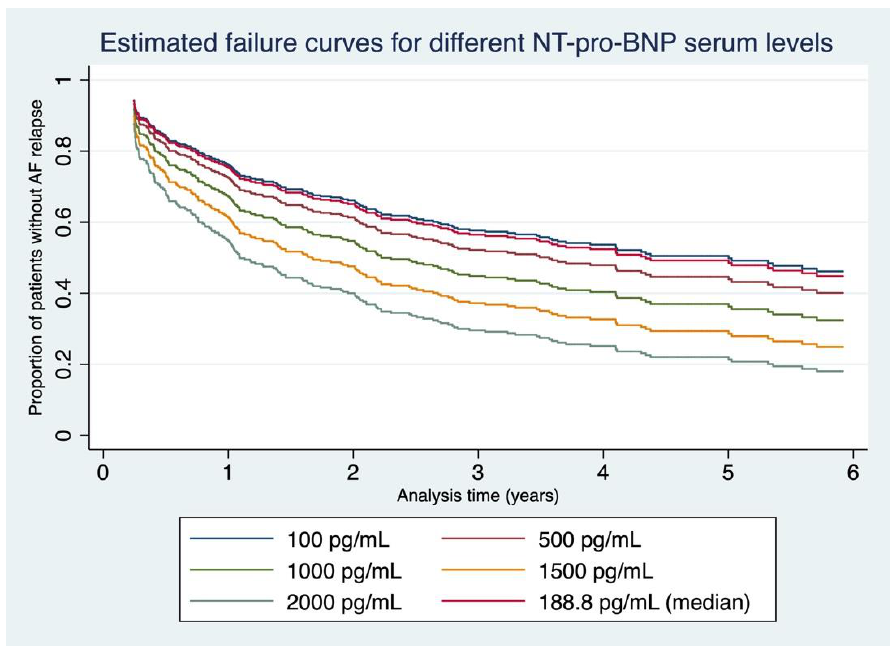
Figure 2. Estimated failure curves for different NT-pro-BNP serum levels. Different failure curves derived from our data depicting estimated AF relapses for the first six years after the first-ever cryo-PVI for baseline NT-pro-BNP levels between 100 and 2000 pg/mL.